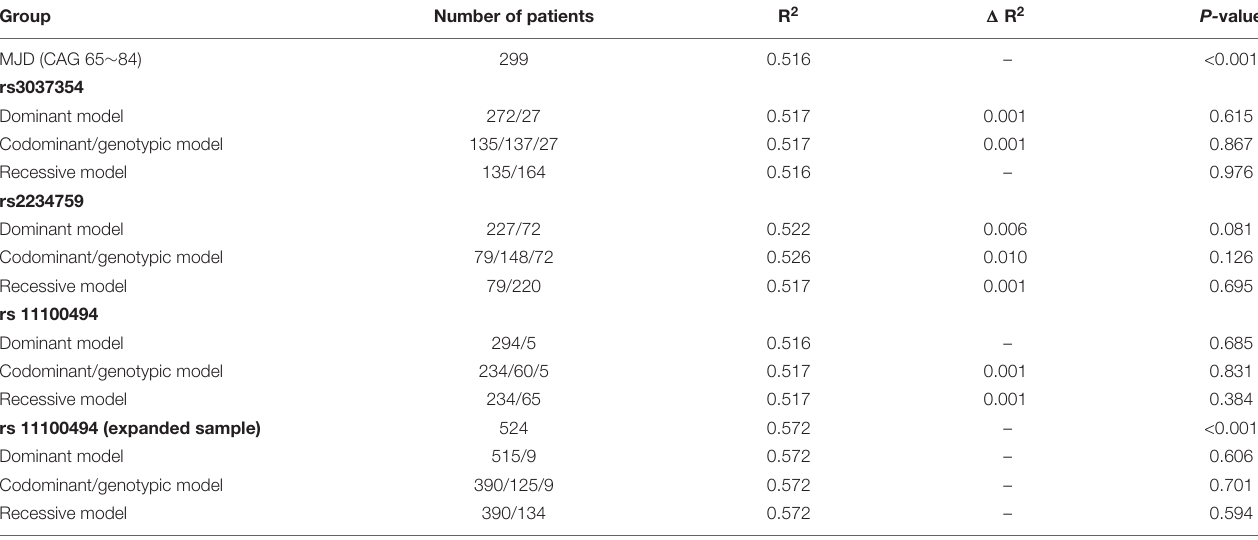
TABLE 3 | Regression analysis of SNPs in NPY and receptor genes in AO of MJD. Group